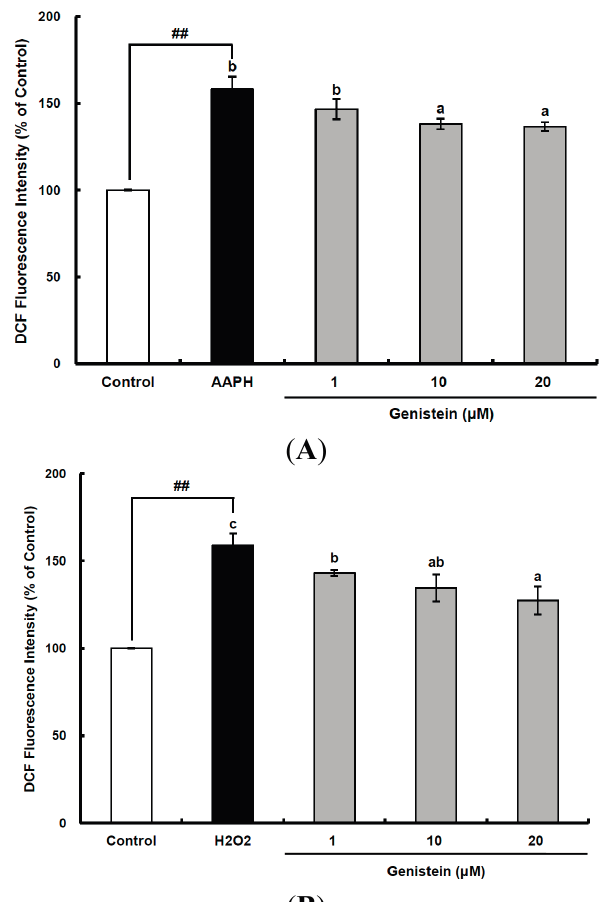
Figure 1. Cellular antioxidant capacity of genistein against oxidative stress induced by 2,2'-azobis(2-amidinopropane) dihydrochloride (AAPH) ( A ) and H HepG2 cells were first cultured in 96-well plates (5 × 10 5 /mL) with Dulbecco’s modified Eagle’s medium (DMEM) for 24 h. After the cells were incubated with different concentrations of sample dissolved in dimethylsulfoxide (DMSO) for 30 min, Hank’s balanced salt solution (HBSS), which is fluorescently stable, was then added to each well. After the cells were treated with 60 μ M AAPH or 1 mM H 2',7'-dichlorodihydrofluorescein-diacetate (DCFH-DA) was added to the culture plates at a final concentration of 40 µM, and the cells were incubated for 30 min at 37 °C in the dark. Then, the cells were washed with HBSS and 2',7'-dichlorofluorescein (DCF) fluorescence intensity was measured at an excitation wavelength of 485 nm and an emission wavelength of 535 nm using a Tecan GENios fluorometric plate reader. Data are expressed as percentages of the value of untreated cells (mean ± standard deviation, n = 3). Different corresponding letters indicate significant differences at p < 0.05 by Duncan’s test. ## p < 0.01 vs.